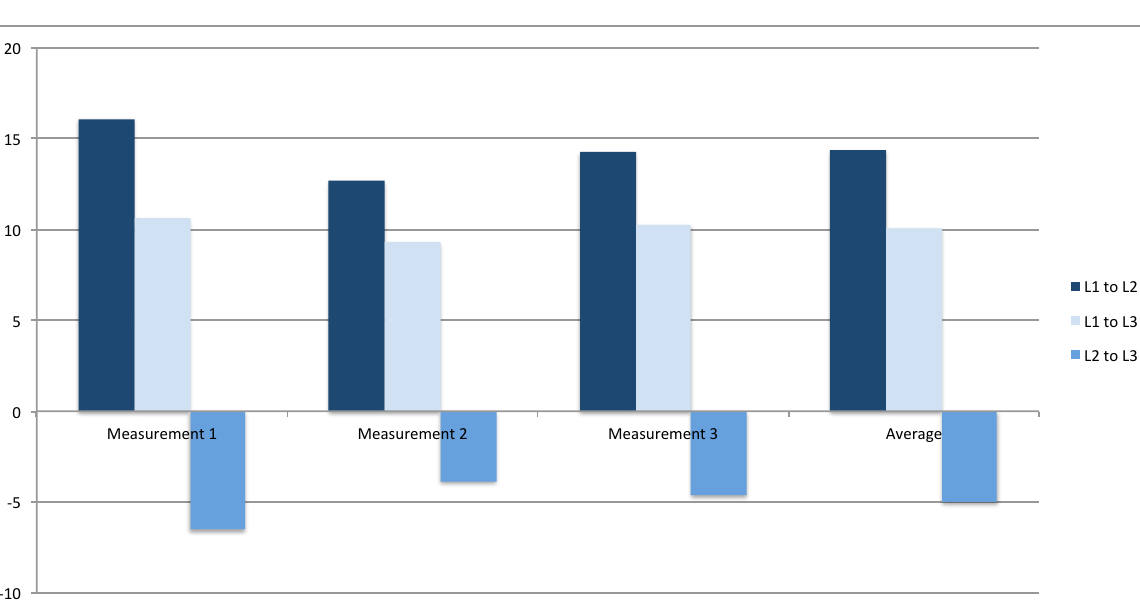
Figure 6. Energy savings of all intelligence